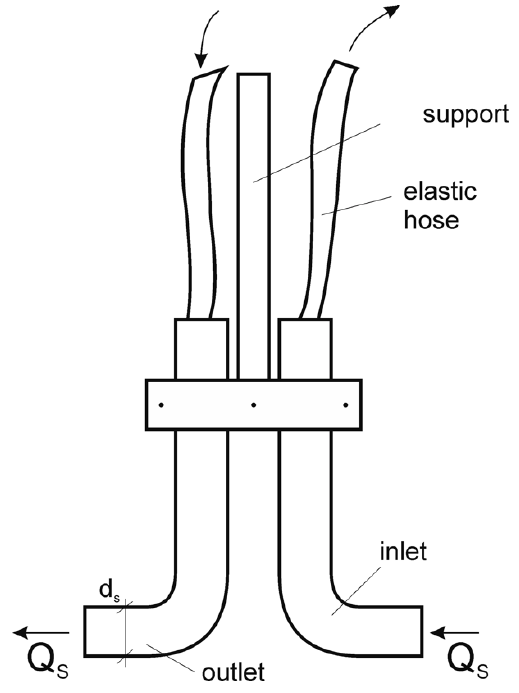
Figure 2. Sketch of a stream pump.